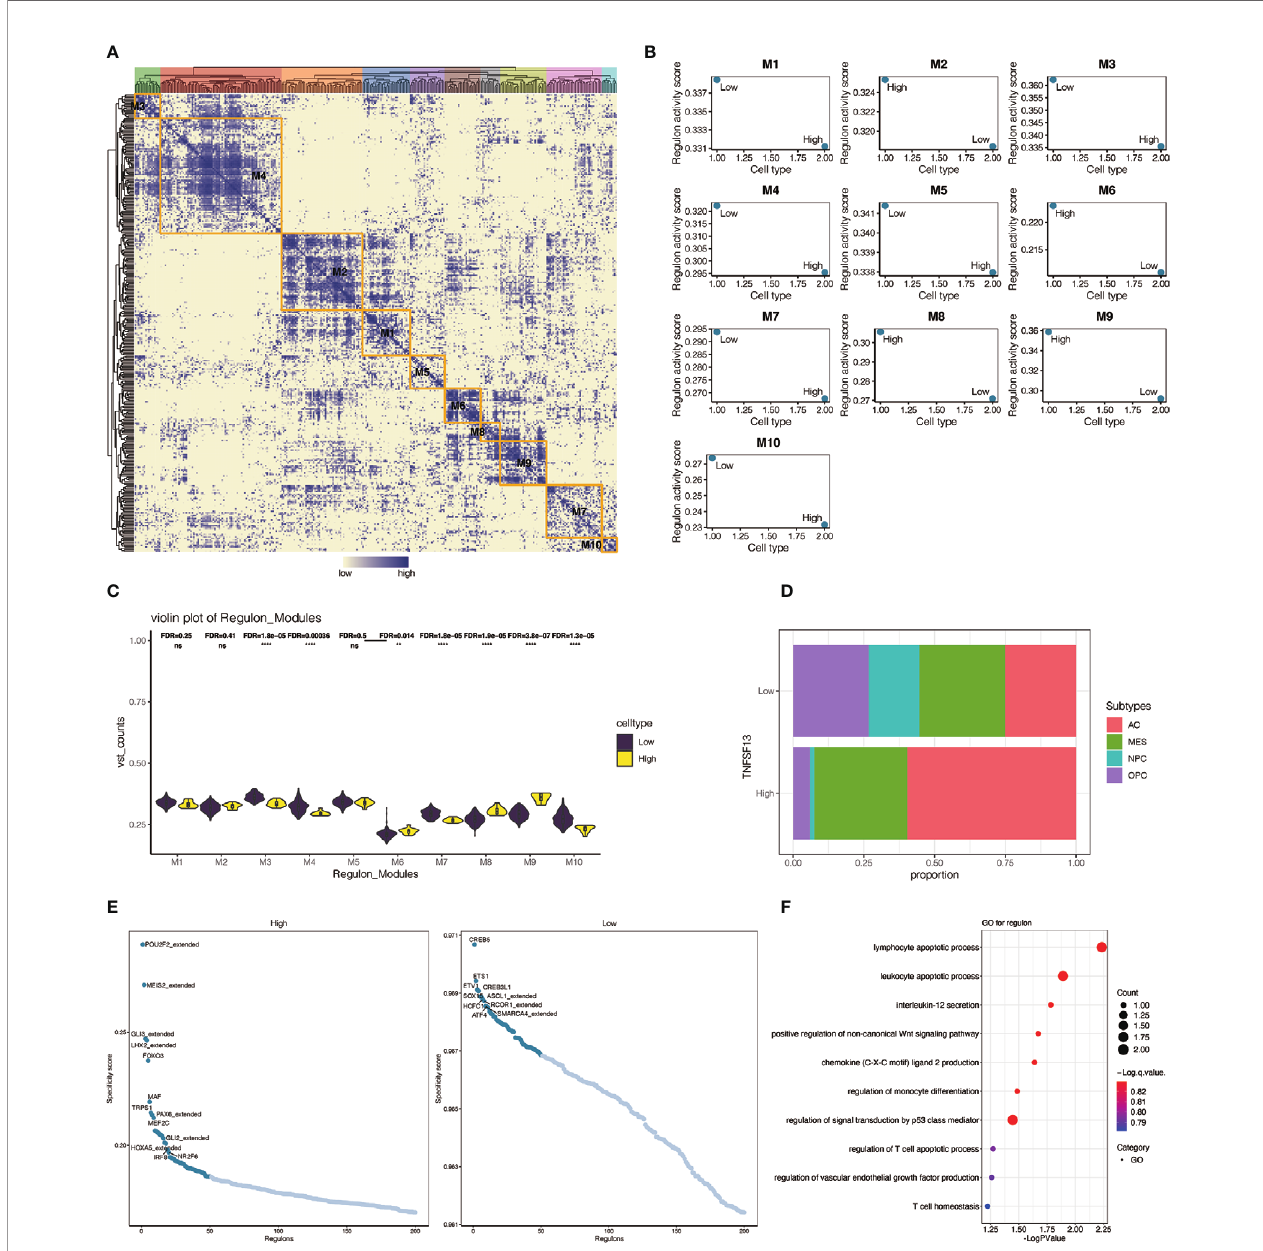
FIGURE 8 | Interrelationship between transcription factors in malignant cells. (A) Heatmap of nine modules of transcription factors in malignant neoplastic cells. (B) Regulon activity scores of TNFSF13 high and TNFSF13 low malignant cells in nine modules based on transcription factors. (C) Violin plot for the distribution of TNFSF13 high and TNFSF13 low malignant cells in nine modules based on transcription factors. (D) Proportion of high and low TNFSF13 expression malignant neoplastic cells in four cellular states. (E) Scatter plot for the speci fi city score of transcription factors in high and low TNFSF13 expression malignant cells. (F) GO enrichment analysis based on high expression regulons in malignant cells. ns, not statistically signi fi cant; **P < .01, ****P <